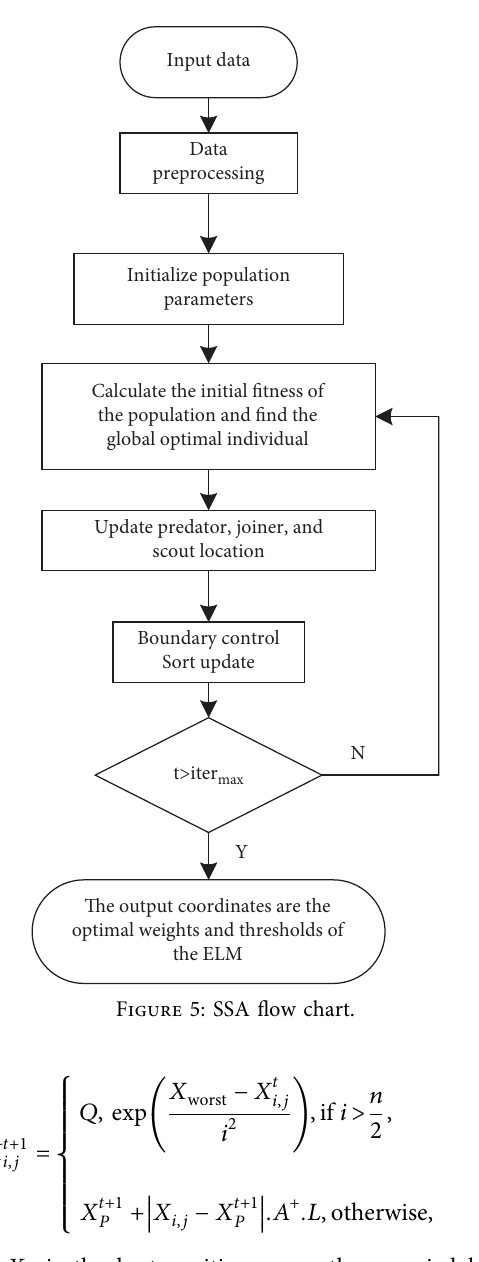
Figure 5: SSA fow chart.